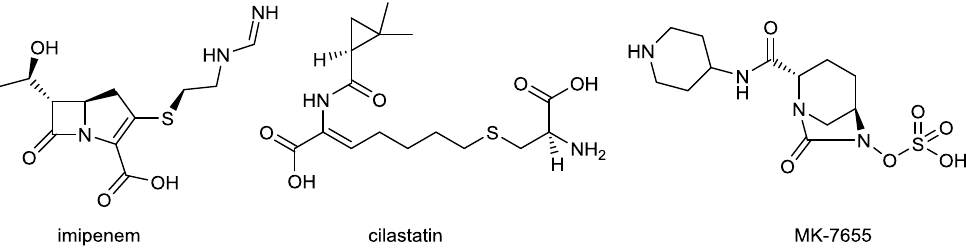
Figure 5. Chemical structures of imipenem, cilastatin, and MK-7655.